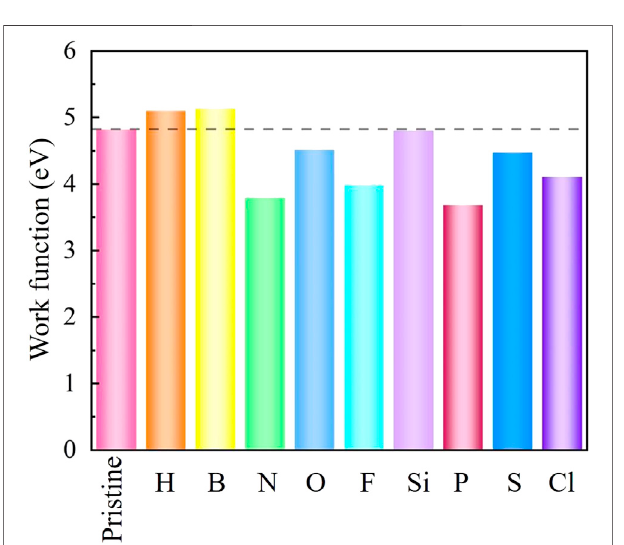
FIGURE 5 | The work function of the intrinsic SiC and NM-SiC systems.